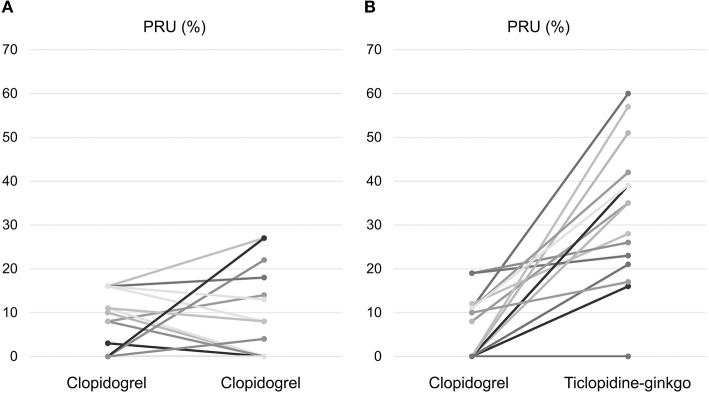
Changes in P2Y12 Reaction Units. Change in P2Y12 Reaction Units in the (A) clopidogrel and (B) ticlopidine–ginkgo group.